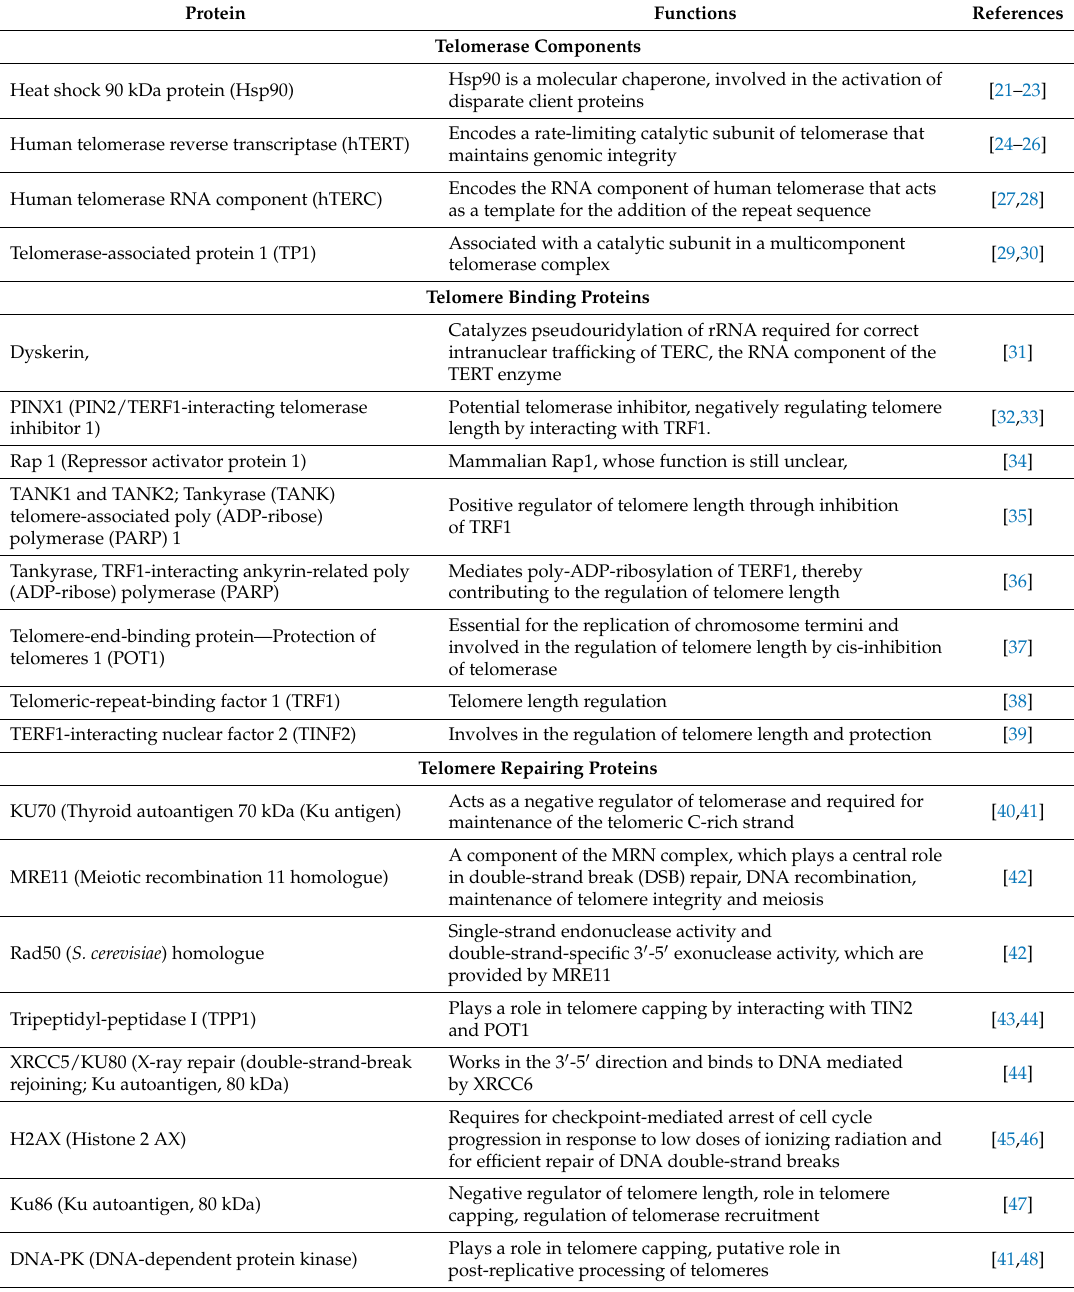
Table 1. Telomere and telomerase-associated